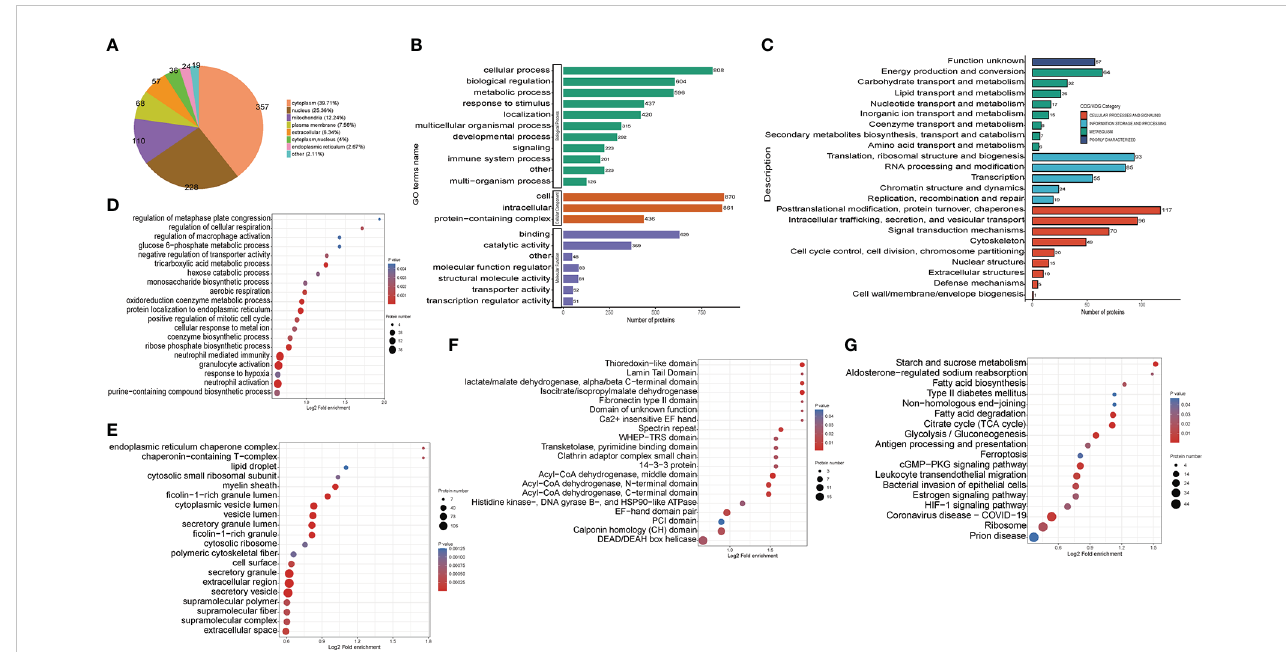
FIGURE 4 Functional classi fi cation of down-regulated crotonylated proteins in THP1 cells infected by MRSA for 3 hours then treated by vancomycin for 0.5 hours compare with control cells. (A) Pie chart of the percentage and number of down-regulated crotonylated protein. (B) Bar graphs showing GO-based enrichment analysis of the down-regulated crotonylated proteins. (C) COG/KOG category analysis. (D) Biological Process category analysis. (E) Cellular Component category analysis. (F) Down regulated domain. (G) KEGG pathway